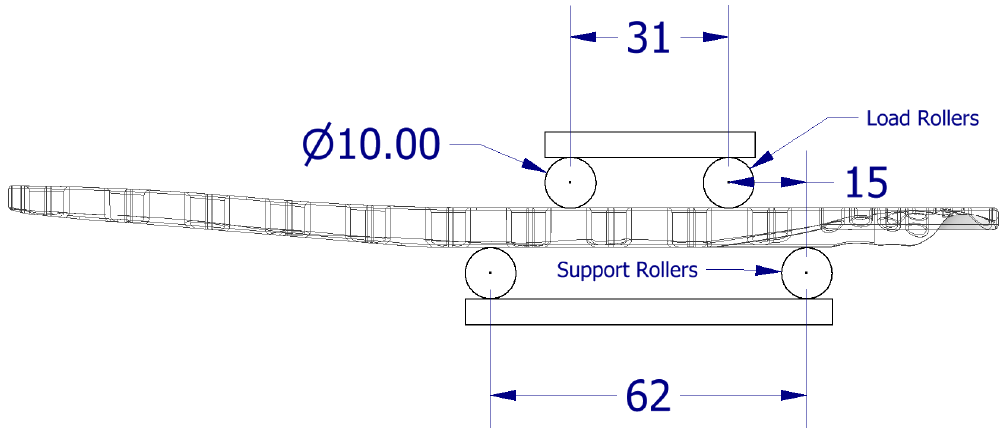
Figure 3. Four-point bending condition of ‘INT-BP’ plate, dimensions in mm.